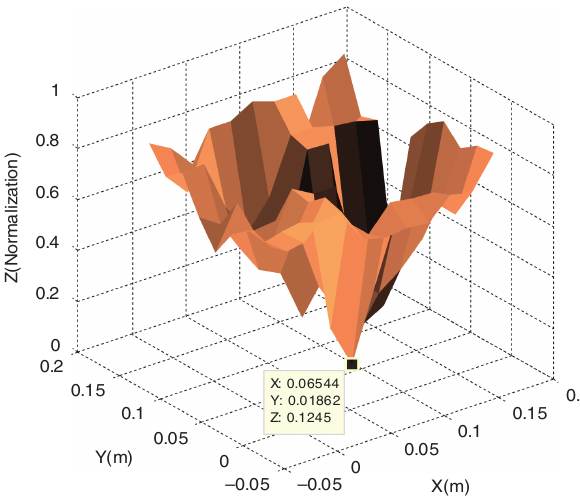
Figure 3: The mutual coupling between the position of material along Z axis and the position of microwave source along Z axis at 2.45GHz. Note: X(m): load position along Z axis (m); Y(m): position of feeding port along Z axis (m); Z: Reflection coefficient